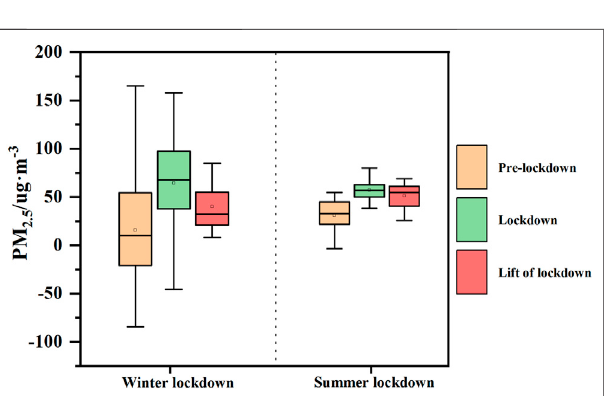
FIGURE 2 | Deviation between historical and lockdown periods for PM 2.5 concentrations during the winter and summer lockdowns in Urumqi.